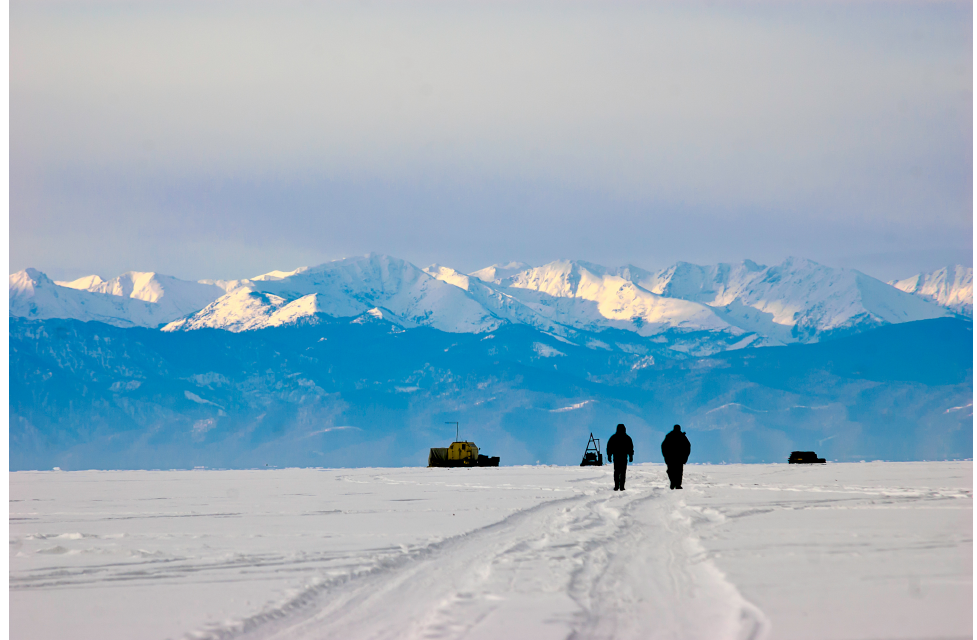
Figure 3. An overview of the launch site on the Baikal Lake from the shore. The background mountains are more than 50 km away, which indicates good atmosphere transparency on the ground level.